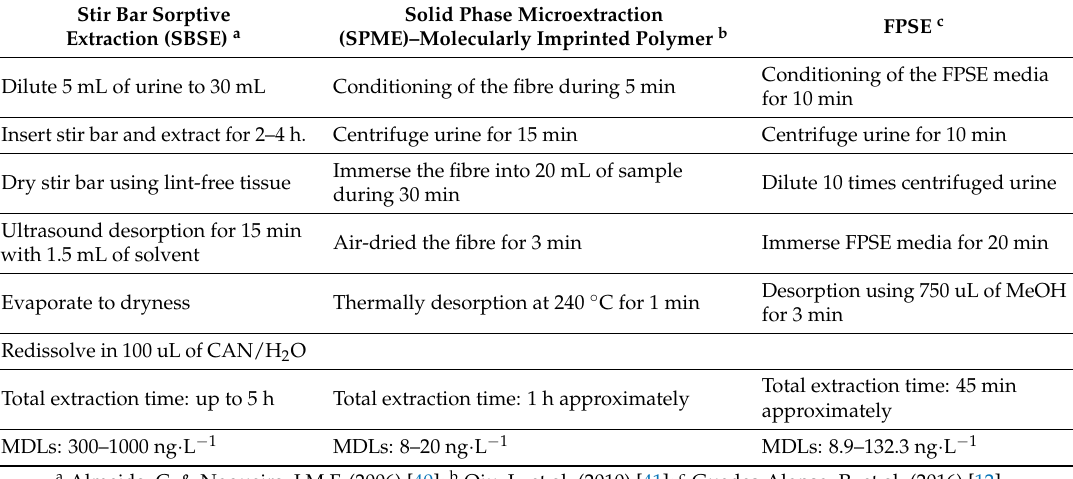
Table 2. Comparison of microextraction techniques used to extract steroid hormones from urine samples.